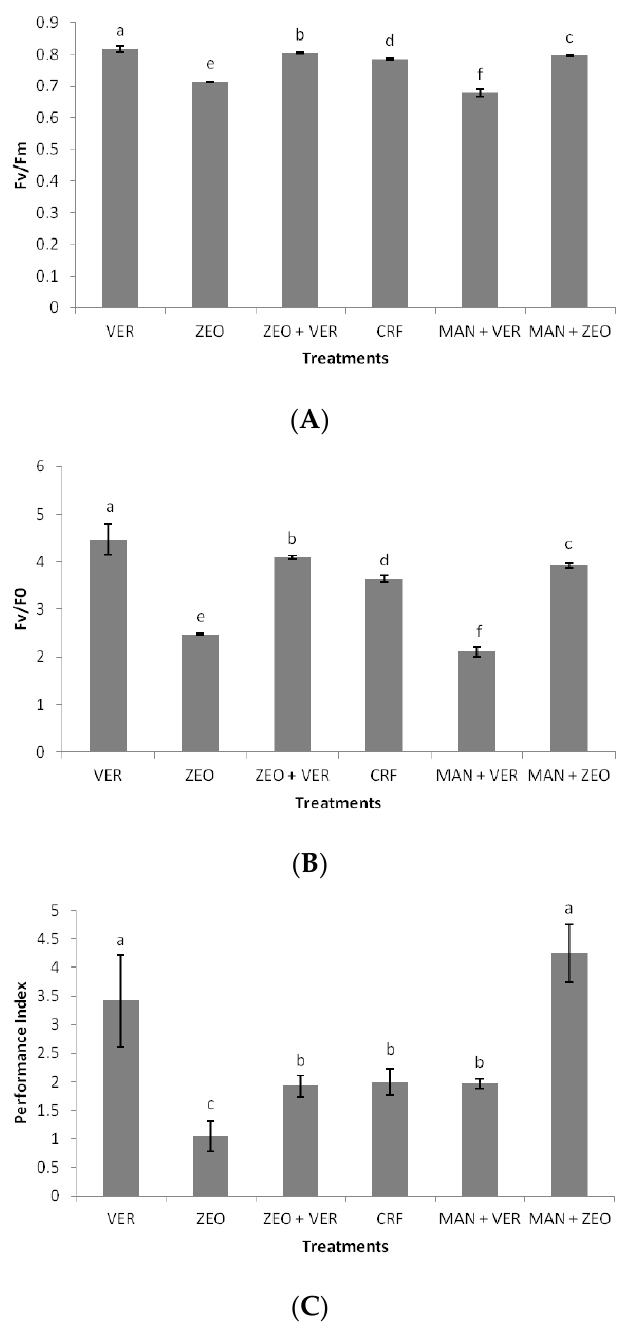
Figure 3. Photosystem II activity, as expressed by the chlorophyll fluorescence parameters F v /F m ( A ), F v /F 0 ( B ) and performance index ( C ), of pepper plants among the treatments. The different letters on the bars signify statistically significant differences among the treatments, according to Duncan’s multiple range test, for p ≤ 0.05. VER: vermiculite; ZEO: zeolite; CRF: controlled-release fertilizer; MAN: